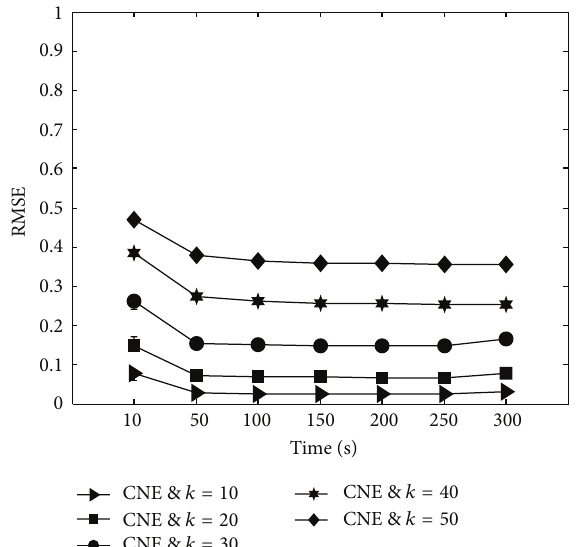
Figure 5: Variations of estimation errors in the CNE protocol with 1 beacon/second beaconing rate versus network initialization in one- hop topology networks deployed in outdoor